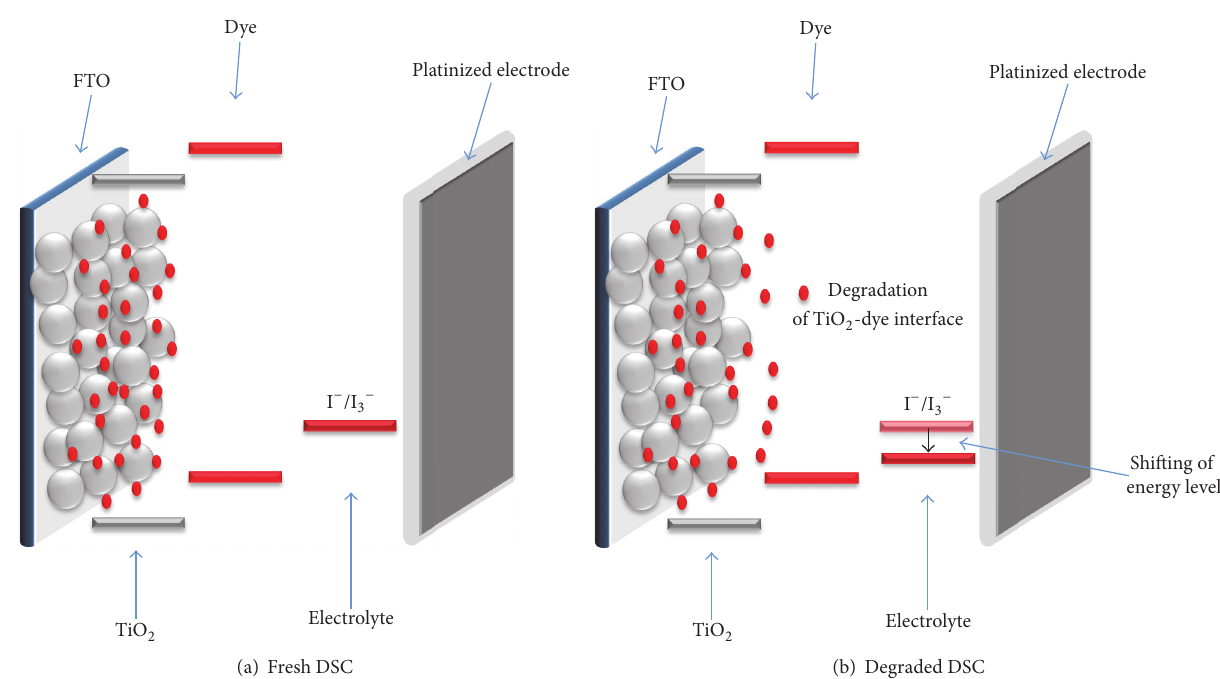
Figure 1: Schematic diagram representing the components of (a) fresh DSC and (b) degraded